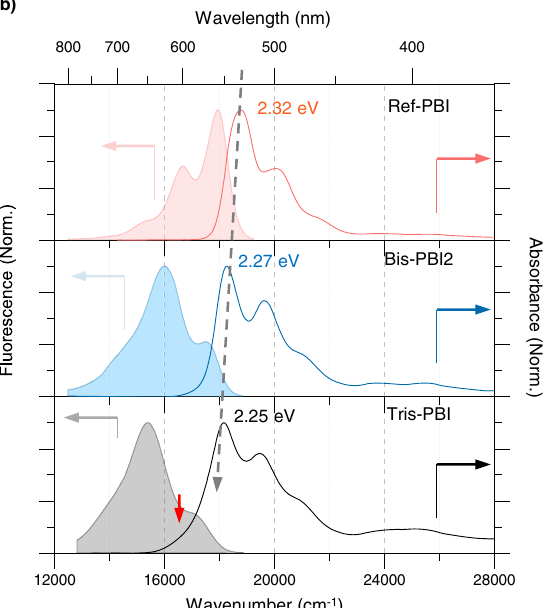
Fig. 1 | The molecular structure and basic optical properties of Tris-PBI. a Schematic molecular structure of Ref-PBI , Bis-PBI2 , and Tris-PBI with the branched 2-hexyldecyl substituents originating from racemic amine precursor. b The normalized steady-state absorption (solid) and fl uorescence ( fi lled area)